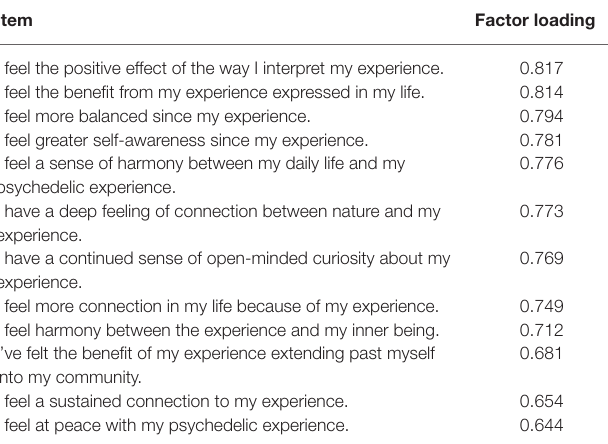
TABLE 9 | EFA component matrix for the experienced integration